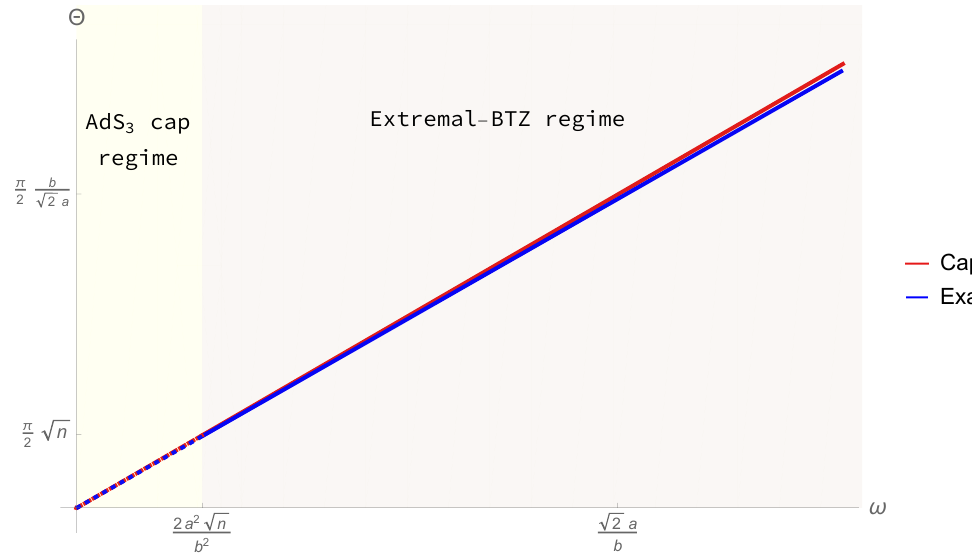
Figure 8: The spectrum function determined by the WKB function Θ (2.20) as a function of Ω . The graph in blue corresponds to the numerical value of Θ with the full (1,0,n)-superstratum potential (4.25). The graph in red corresponds to the cap spectrum given by (5.4). The graphs have been computed for ∆ = 3, k = 1, a = 1, b = 2 10 3 and n = 750 but different parameters give the same